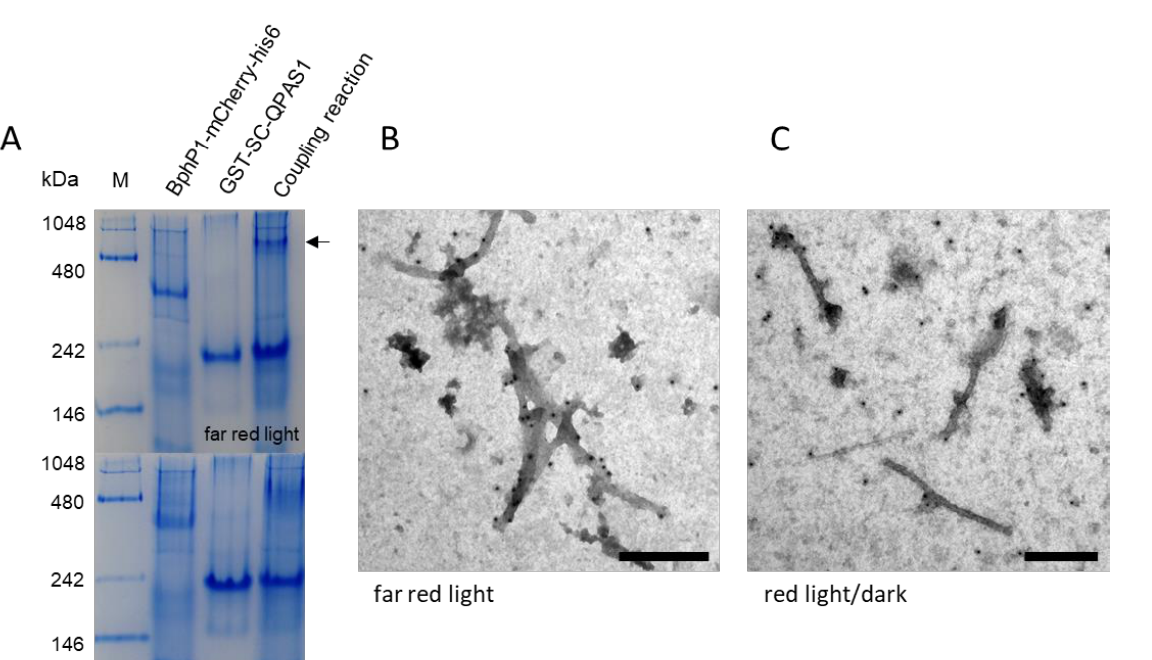
Figure 4. Analysis of the modified BphP1/QPAS1 system. ( A ) Interaction between the purified BphP1 and QPAS1 proteins analyzed by discontinuous native PAGE. Under far-red light, the bands representing the individual proteins BphP1-mCherry-His 6 and GST-SC-QPAS1 are joined by a higher-molecular-weight band (indicated by an arrow) representing the complex, which is not present under red light. M = NativeMark standards. ( B ) Transmission electron micrograph showing the BphP1/QPAS1 system attached to PVX particles. Purified PVX-ST/GST-SC-QPAS1 particles were mixed with BphP1-mCherry-His 6 and incubated for 30 min under far-red light (780 nm). Particles were attached to the grids and BphP1-mCherry-His 6 was detected with an anti-His 6 /GAM-12 nm gold conjugate. Immunogold decoration was observed only for the mixture of PVX-ST/GST-SC-QPAS1 + BphP1-mCherry-His 6 under far-red light (780 nm). ( C ) Transmission electron micrograph showing purified PVX-ST/GST-SC-QPAS1 particles mixed with BphP1-mCherry-His 6 . The mixture was incubated for 30 min in the dark. Particles were attached to the grids under red light or in the dark and BphP1-mCherry-His 6 was detected with an anti-His 6 /GAM-12 nm gold conjugate. No immunogold decoration was observed for the particles. Scale bar = 250 nm. Controls are shown in Figure S2.